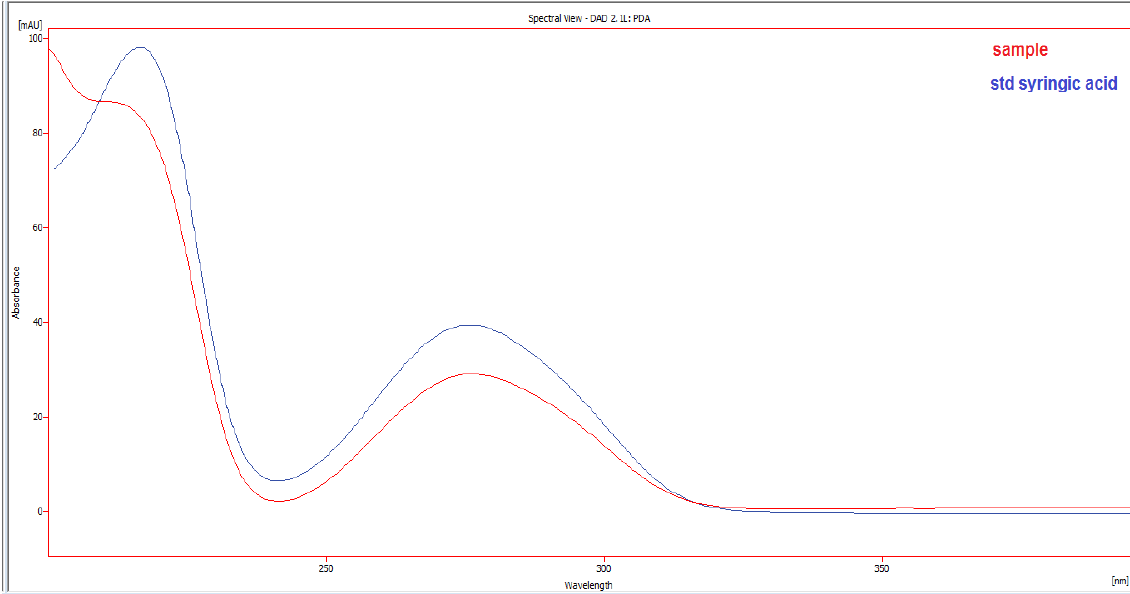
Figure 5. UV spectrum of fraction of ethyl acetate matched with syringic acid standard UV spectrum